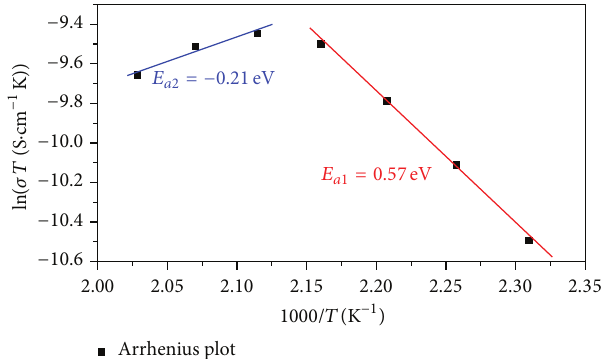
Figure 7: Arrhenius plots of the conductivity of polymer (P 2 ) solid solutions.